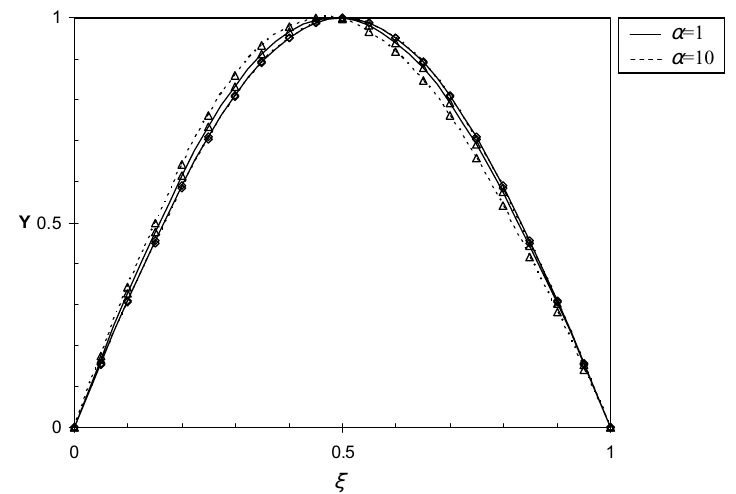
Fig. 3. The mode shapes of a simply supported beam with a uniformly distributed spring-mass in respect to different positions and mass density ratios, ( ξ 1 = 0 . 0 , ξ 2 = 0 . 5 ), ( ξ 1 = 0 . 25 , ξ 2 = 0 . 75 ).